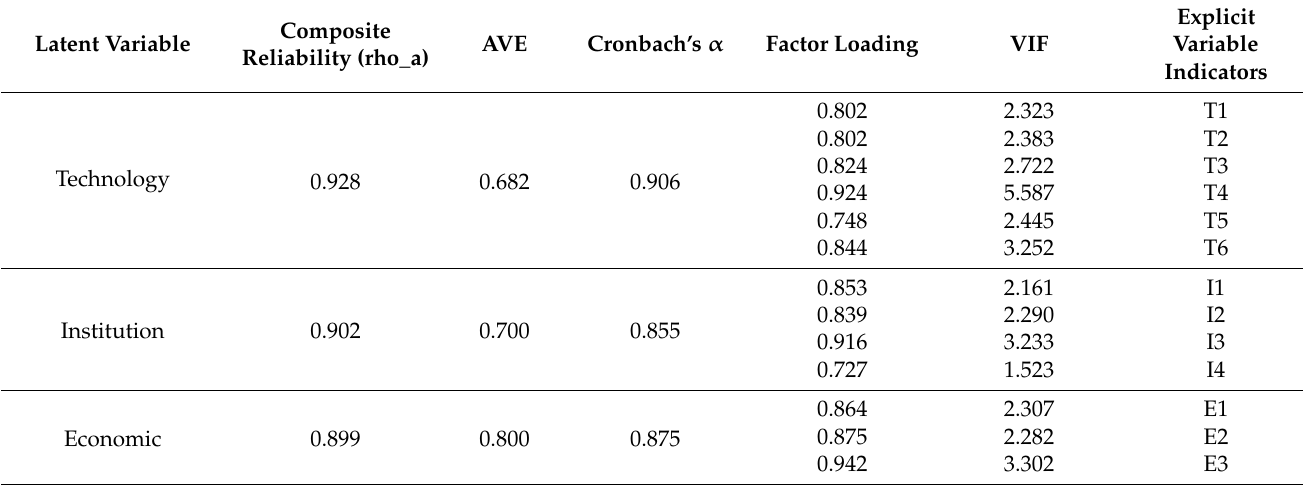
Table 5. Indicator means and the loadings of the latent composites.